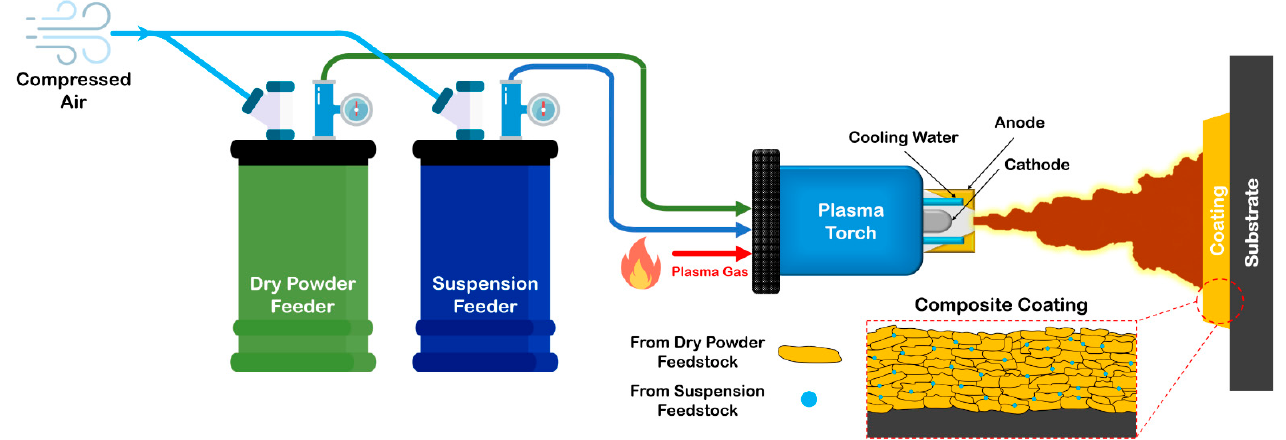
Figure 6. Schematic representing the hybrid plasma spray setup and the composite coating architecture.